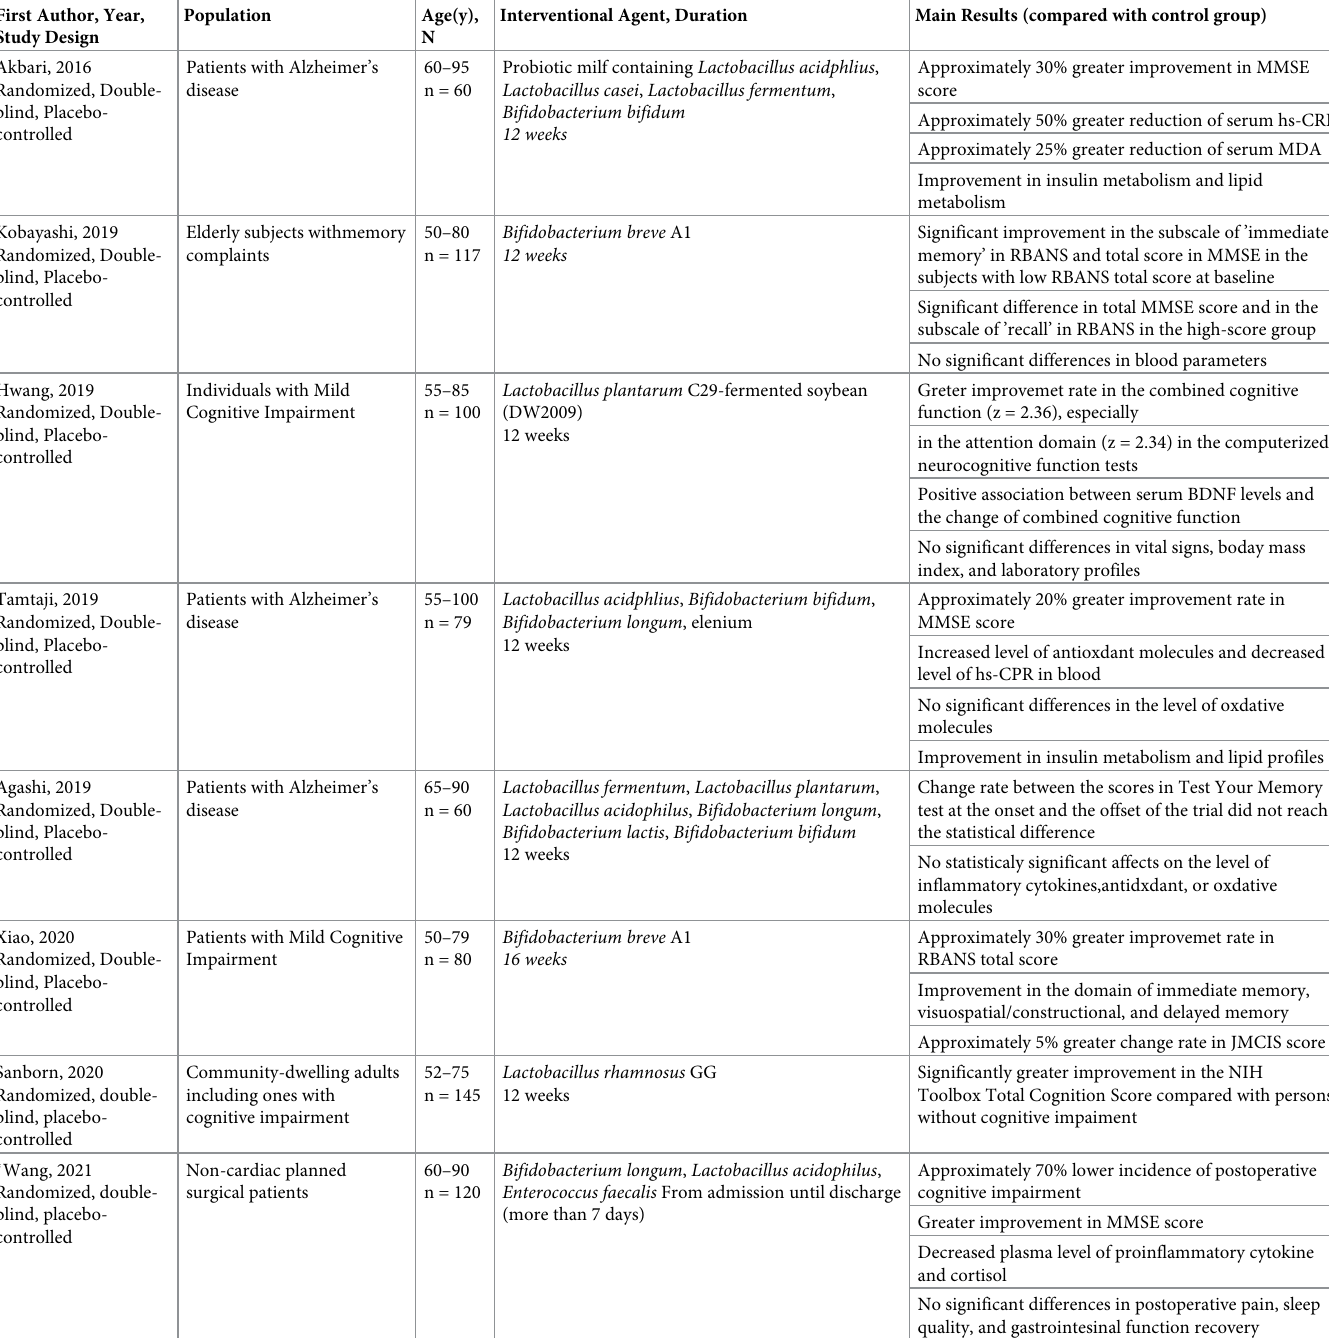
Table 3. Summary of interventional clinical trials on cognitive function in populations with cognitive